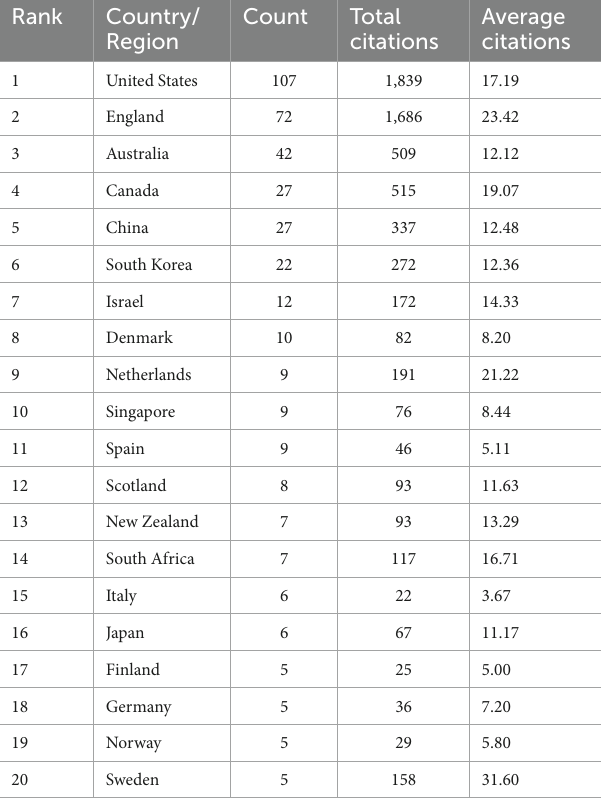
TABLE 1 Most productive countries (minimum five